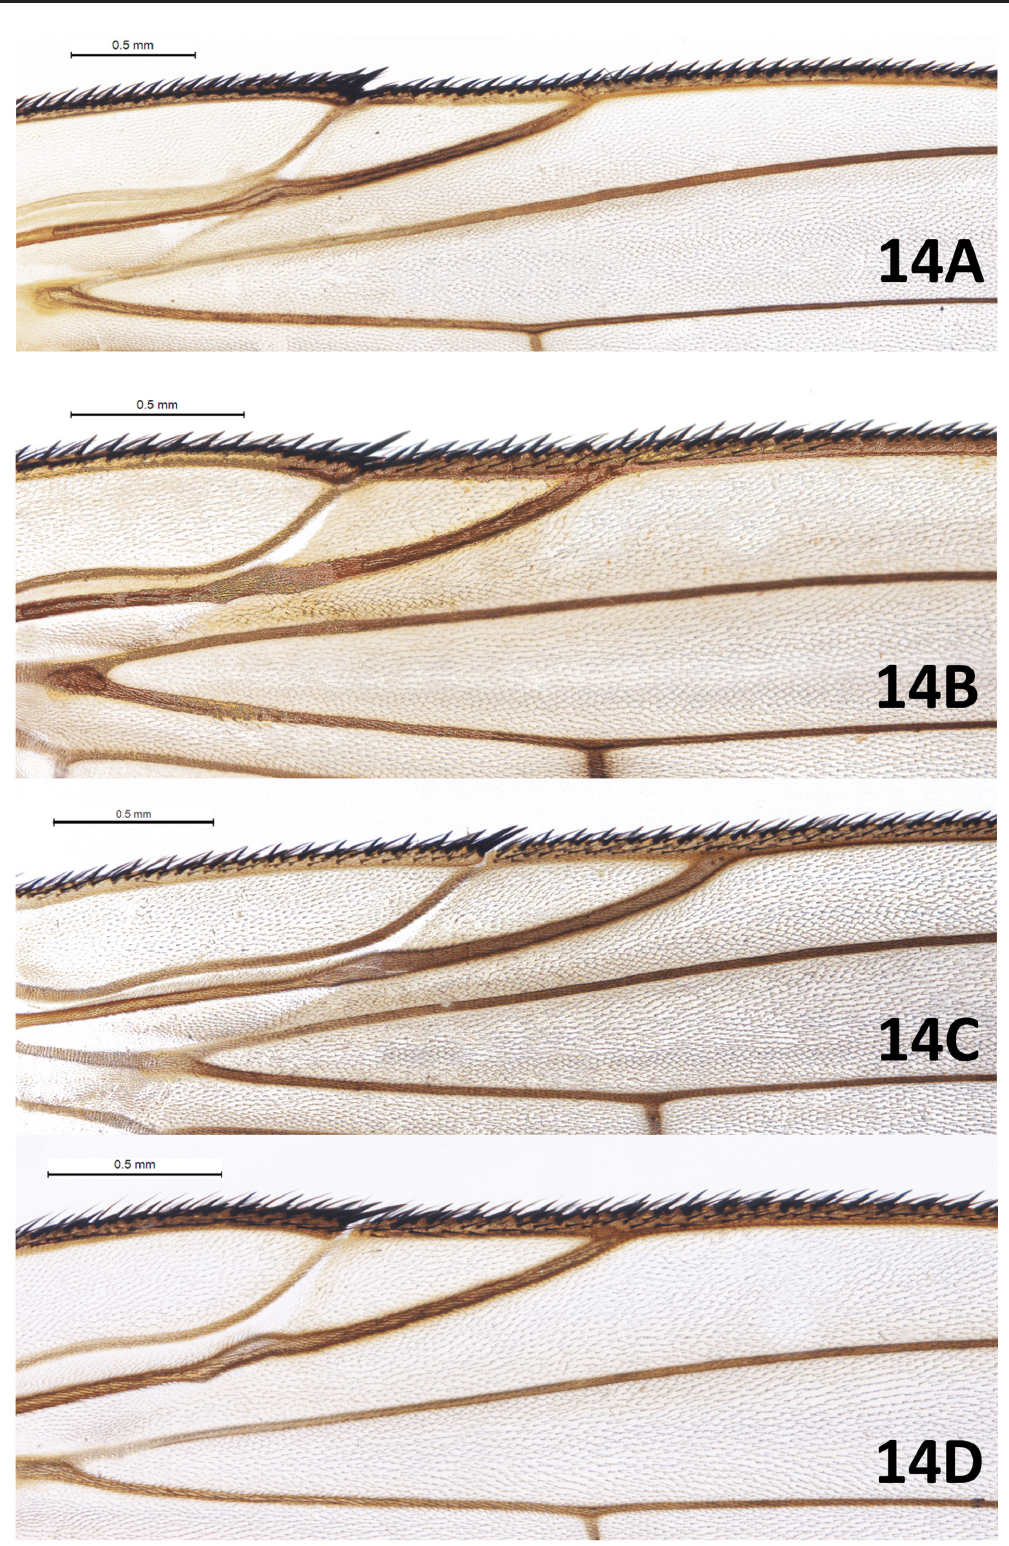
Fig. 14. ♀♀ of Phaonia Robineau-Desvoidy, 1830. A . P . angelicae (Scopoli, 1763), detail of wing showing CS1‒3, dorsal view. B . P . palpata (Stein, 1897), detail of wing showing CS1‒3, dorsal view. C . P . rufiventris (Scopoli, 1763), detail of wing showing CS1‒3, dorsal view. D . P . canescens Stein, 1916, detail of wing showing CS1‒3, dorsal